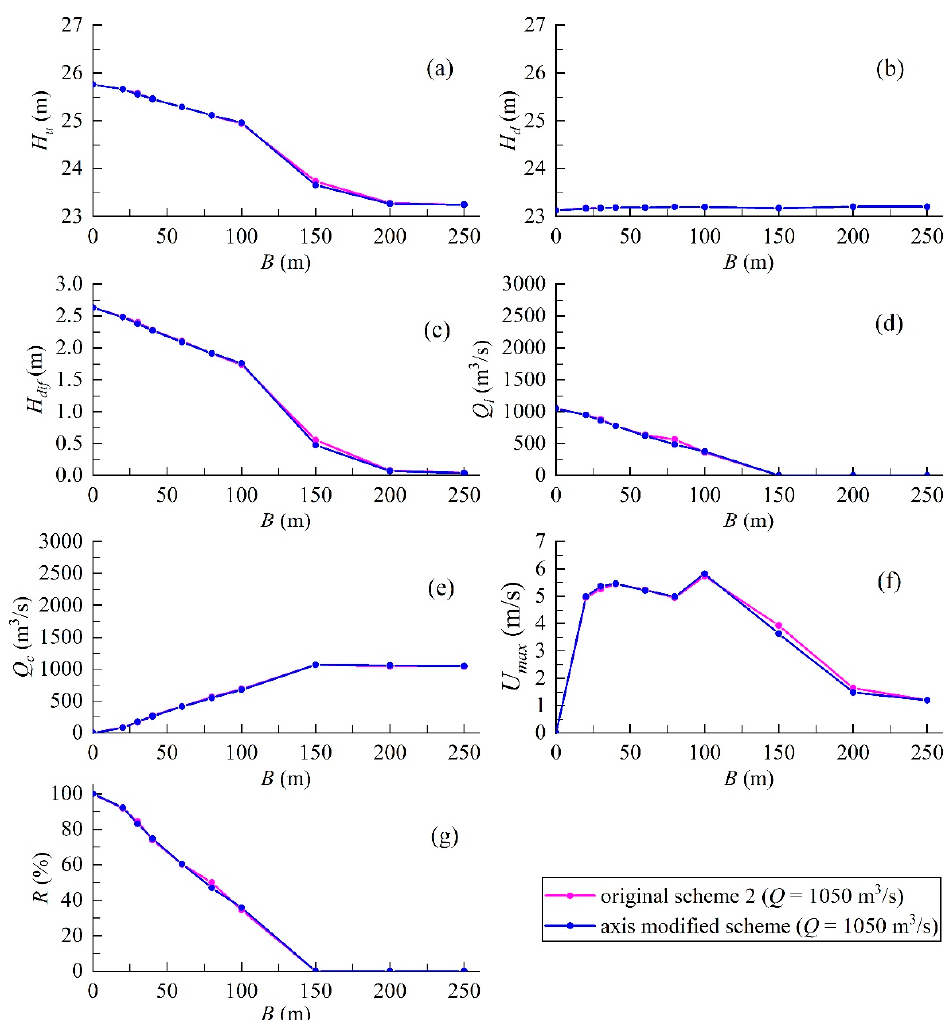
Figure 13. Comparison between the numerical results of original scheme 2 and axis modified scheme: ( a ) upstream water level; ( b ) downstream water level; ( c ) water level difference; ( d ) flow rate of low holes; ( e ) flow rate of closure gap; ( f ) maximum velocity; ( g ) split flow rate .